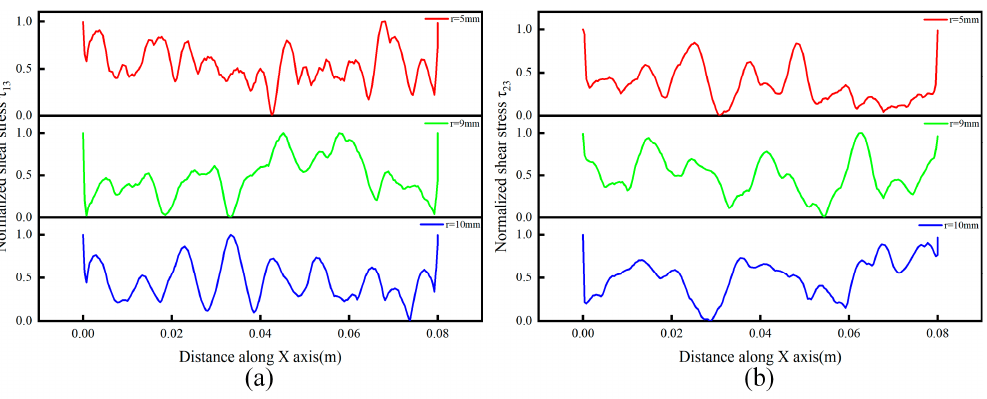
Figure 13. Normalized shear stress amplitude varies along the X axis: ( a ) shear stress τ 13 ; ( b ) shear stress τ 23 .